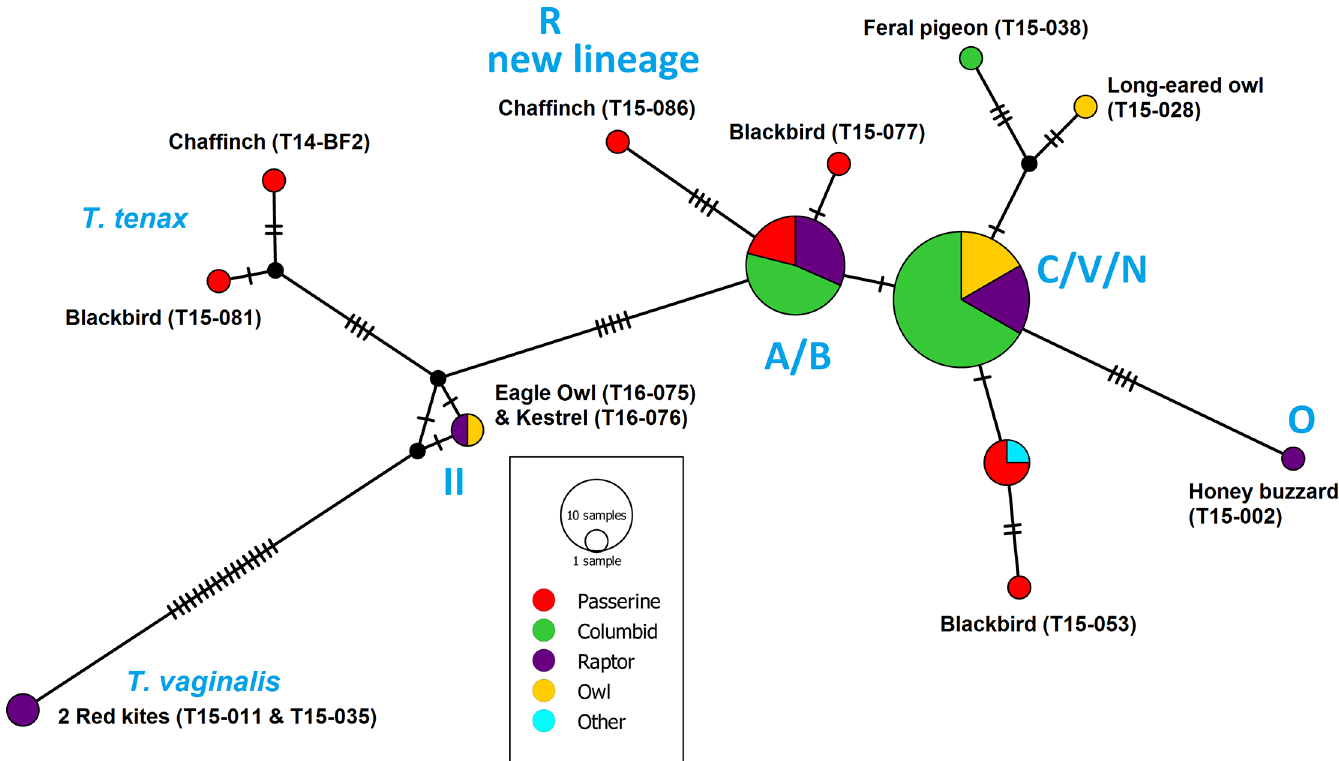
Fig 1. Median-joining haplotype network of the ITS1/5.8S/ITS2 ribosomal region of 71 Trichomonas sequences from samples of birds. The size of the colour coded circles is proportional to haplotype frequency. The hatch marks on the lines represent mutational steps.